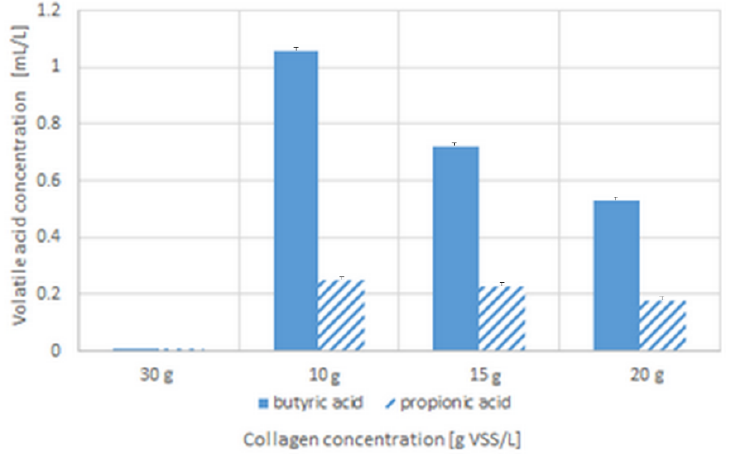
Figure 5. Volatile acid concentrations after 55 days of anaerobic fermentation of gelatine concentra- tions from 10 g VSS/L to 30 g VSS/L.